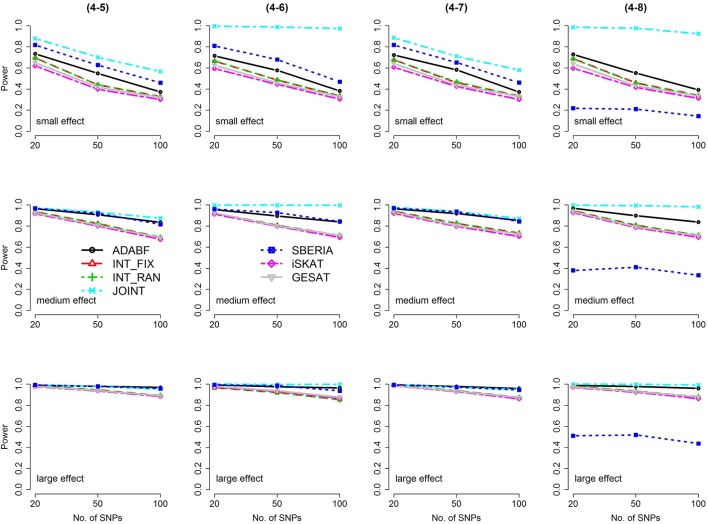
Power of the seven tests for continuous traits (4 SNP × E, from Scenario 4-5 to 4-8). The x-axis represents the number of SNPs in the gene, whereas the y-axis depicts the power at the nominal significance level α = 2.5 × 10−6. From the top row to the bottom row, the magnitudes of SNP main effects and SNP × E interaction effects were evaluated at three levels: small, medium, and large, respectively.